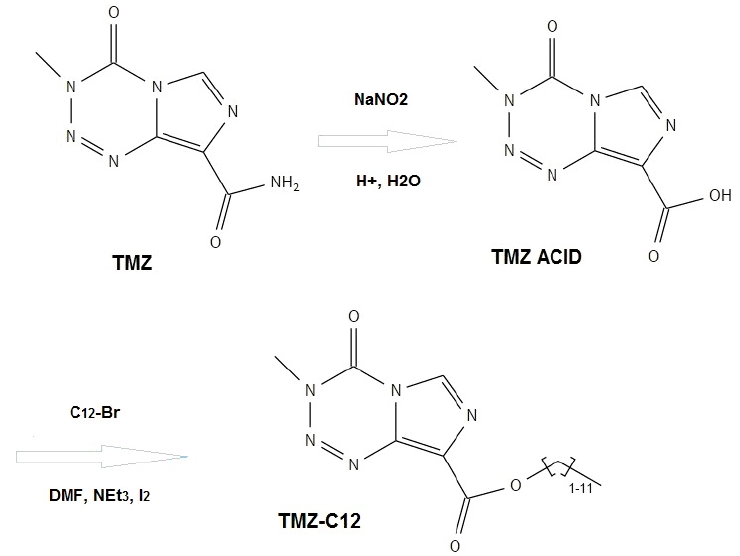
Figure 12. Scheme of TMZ-C12 synthesis.